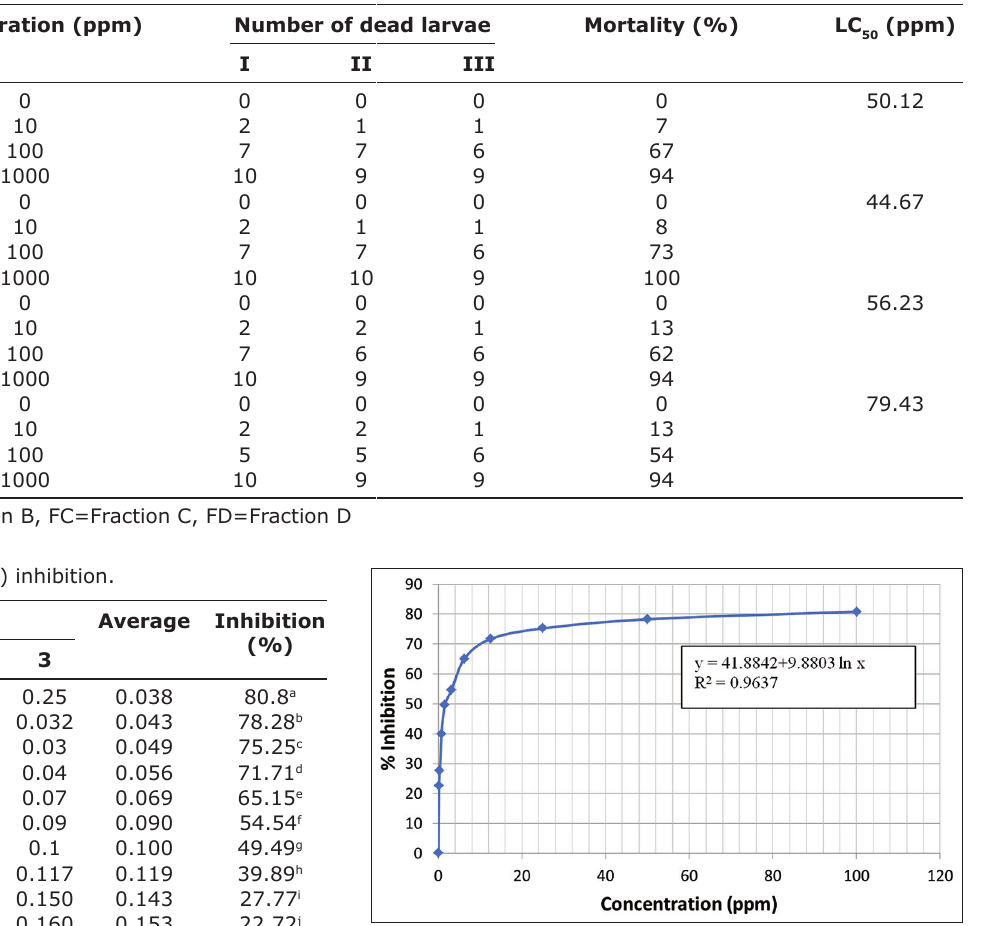
Figure-1: The curve correlation between sample concentration and